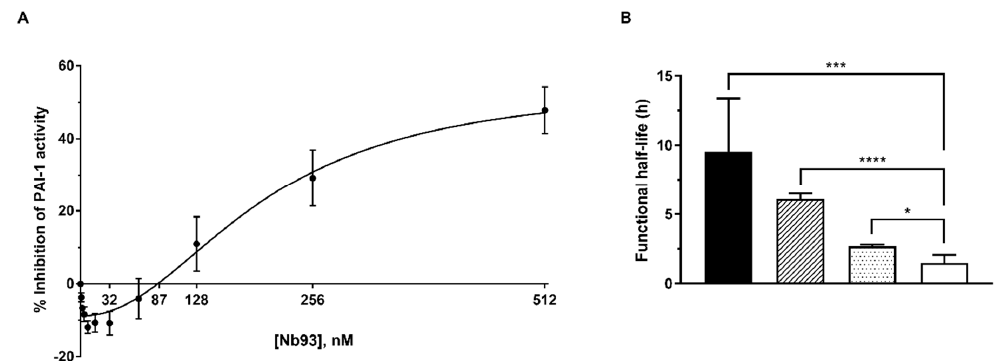
Figure 5. Evaluation of the inhibitory and stabilizing effects of Nb93 on active PAI-1. ( A ) Biphasic dose–dependent response of Nb93 on wild-type PAI-1 (PAI-1-wt) activity, characterized by a stabilizing effect at concentrations below and an inhibitory effect at concentrations above 87 nM; ( B ) The functional half-life of active PAI-1-wt in the absence (open bars) or the presence of 64 nM Nb93 (black bars), 32 nM Nb93 (hatched bars) or 64 nM Nb42 (dotted bars). All data are represented as mean ± SD; n ≥ 3. * p < 0.05, *** p < 0.001, **** p < 0.0001.